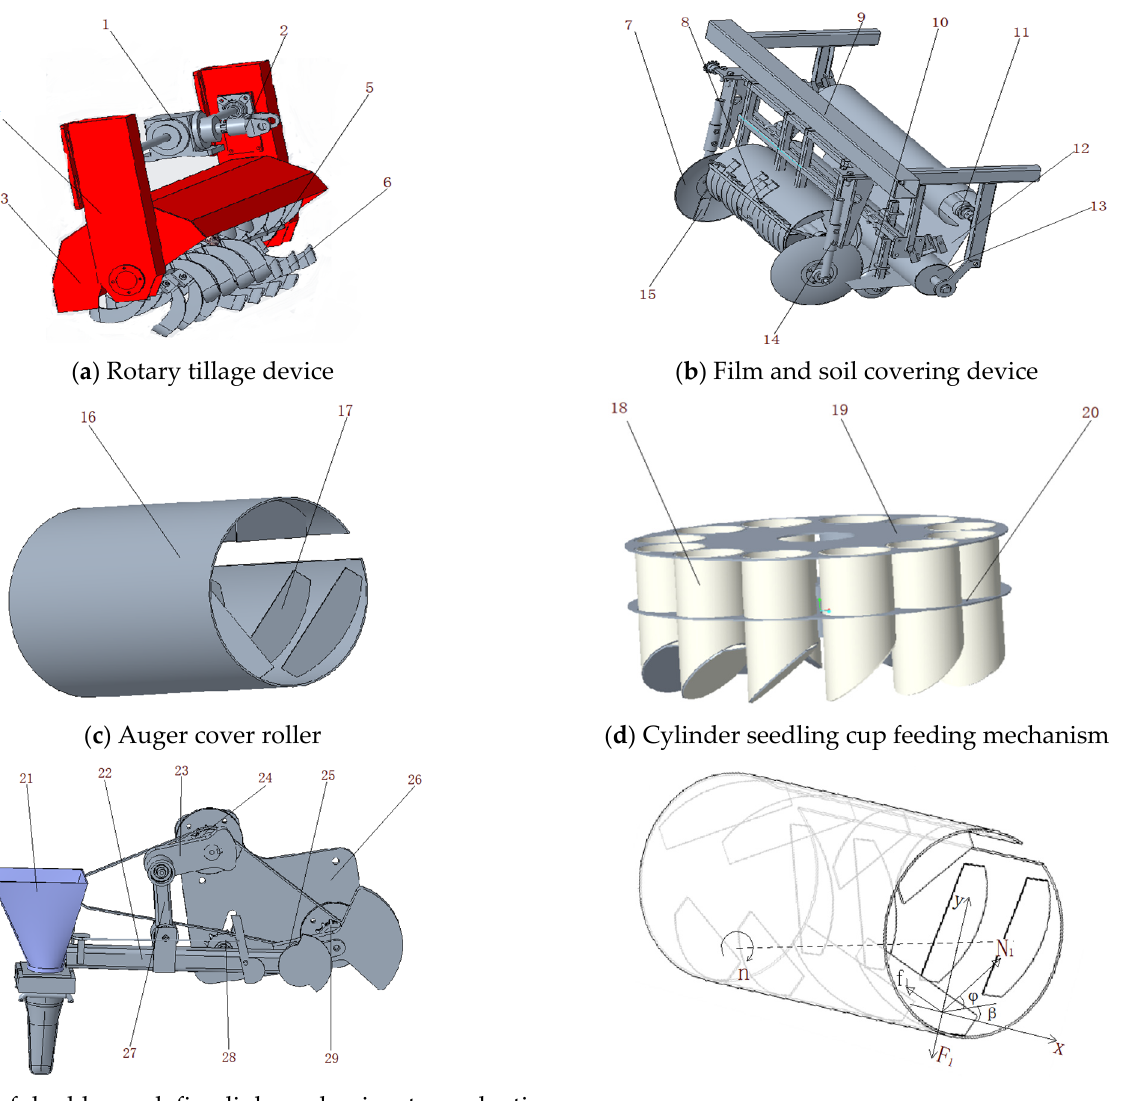
Figure 3. Key mechanisms of the transplanter. 1. Transmission case; 2. Power transmission shaft; 3. Trim shell of rotary tillage device; 4. Transmission housing; 5. Rotary blade shaft; 6. Rotary blade; 7. soil-covered plate; 8. Auger cover roller; 9. The shelf of film and soil covering device; 10. Film-pressure wheel; 11. Film roller suspension rack; 12. Film; 13. Film roller; 14. Installation support; 15. Soil-retaining plate; 16. The shell of auger cover roller; 17. Soil guide plate; 18.Seedlings cup; 19. Turntable plate; 20. Seedlings cup bracket; 21. Duckbilled transplanting apparatus; 22. Coupler-1; 23. Crank-1; 24. Gear-1; 25. Crank-2; 26. Connection plate; 27. Coupler-2; 28. Gear-2; 29. Gear-3.